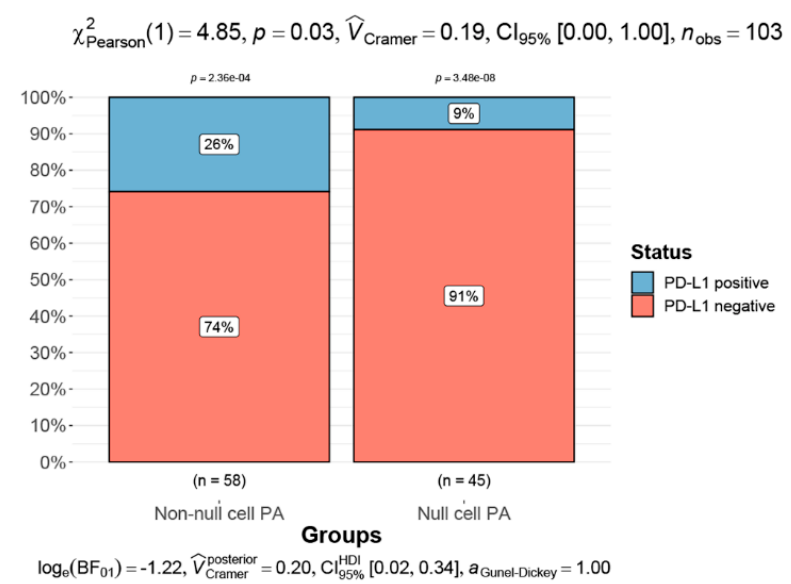
Figure 5. Proportions of positive PD-L1 between null cell and non-null cell groups are compared using the chi-squared test.